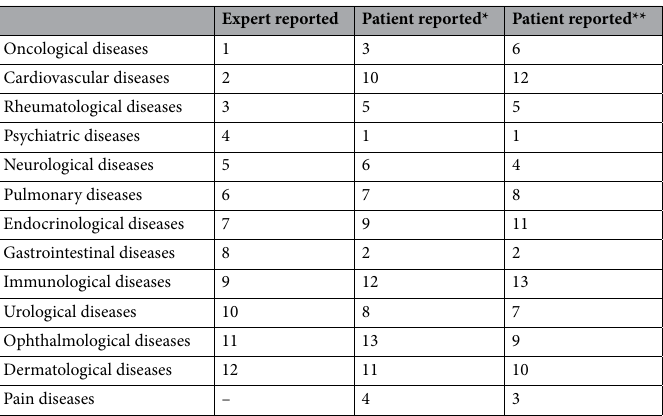
Table 6. Differences between burden of disease rankings. *Patient reported burden of disease ranking without comorbidities. **Patient reported burden of disease ranking with